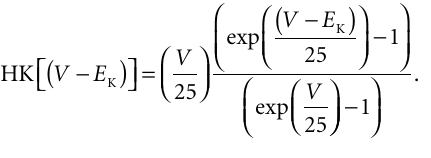
+ dependence of I FIGURE 2 | K in squid axons. The solid curves (labeled o K “b”, for example, in lower left hand corner) are a description of these results by GHK. The dashed lines (labeled “a”) represent Eq. 2 in the text. The diagram in the upper left is a schematic illustration of single “vacancy” ion translocation described in the text.